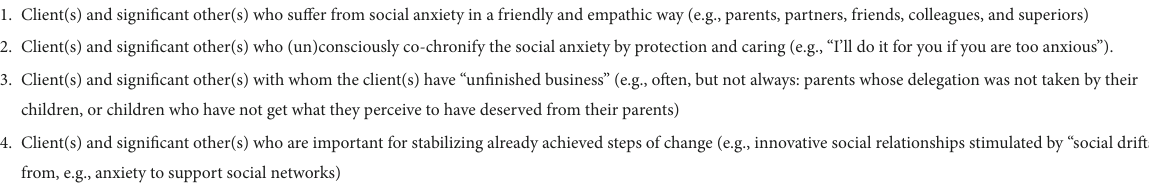
TABLE 4 Inviting social system members into therapy (Schweitzer et al., 2020). Criteria for identifying significant social system